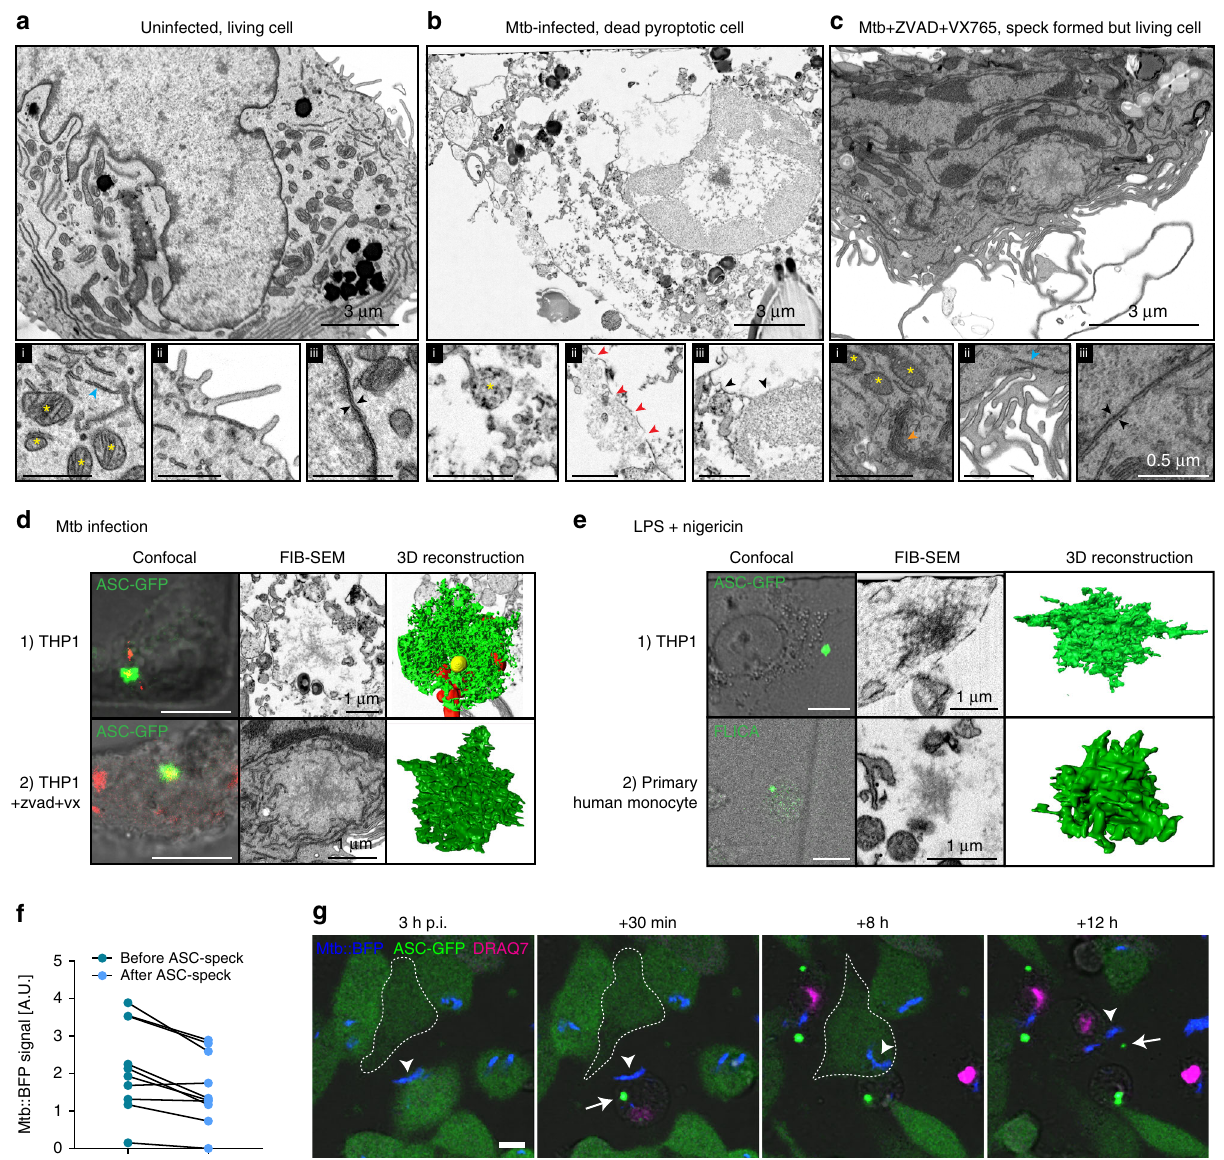
Fig. 2 Pyroptosis causes severe cellular damage and allows for spread of Mtb. Ultrastructural changes induced before and after in fl ammasome activation and cell death in cells infected by Mtb were investigated by FIB – SEM tomography. THP1-ASC-GFP cells were infected with Mtb-BFP and fi xed after ( a , b ) 24 h or ( c ) 5 h in the absence or presence of caspase inhibitors (Z-VAD FMK and VX765), respectively. An ( a ) uninfected, ( b ) infected, pyroptotic and ( c ) infected, living cell with an activated in fl ammasome is displayed. The uninfected cell in ( a ) is from a 24-h infection experiment, but was found to be uninfected from confocal microscopy and FIB – SEM. Insets (i), (ii) and (iii) highlight mitochondria/ER/Golgi, plasma membrane morphology and nuclear membrane morphology, respectively. Yellow stars indicate mitochondria, blue arrowheads ER, orange arrowheads Golgi, red arrowheads plasma membrane ruptures and black arrowheads indicate nuclear membranes. Black inset scale bars represent 1 µ m. Data representative of two independent experiments. d , e Structure of ASC specks induced by Mtb infection or LPS and nigericin (6,7 µ M, 1 – 2 h) treatment in THP1-ASC-GFP cells or primary human monocytes. Monocytes were treated with FLICA caspase-1 reagent for visualisation of active caspase-1 at the in fl ammasome. Cells were imaged by correlative confocal microscopy and FIB – SEM, and ASC specks were reconstructed in 3D from the respective FIB – SEM image stacks. Cell numbers (1) and (2) in ( d ) are the same as in ( b ) and ( c ), respectively. Data representative of two independent experiments. f Quanti fi cation of intracellular Mtb-BFP fl uorescence in single cells before and after ASC speck formation and pyroptosis for n = 10 representative cells. g THP1-ASC-GFP (green) cells in DRAQ7- containing medium (magenta) and infected with Mtb-BFP (blue) imaged by time-lapse confocal microscopy for 24 h. Arrowheads indicate Mtb that is phagocytosed twice during the time course, and arrows indicate ASC specks. Confocal scale bars: 10 µ m. Source data are provided as a Source Data fi